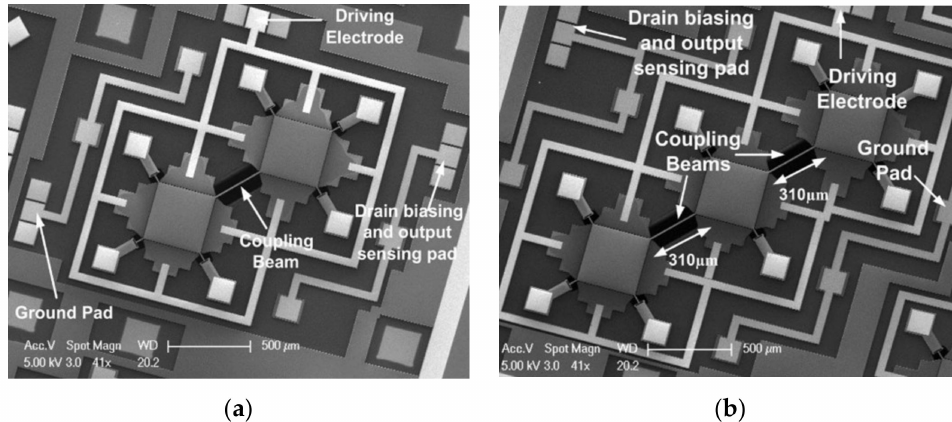
Figure 19. SEM image of the fabricated BAW rectangular-plate resonators with capacitive actuation and piezoresistive sensing setup (Adapted with permission from Ref. [37]). ( a ) A 2-DoF coupled BAW resonator device; ( b ) A 3-DoF coupled BAW resonator device.